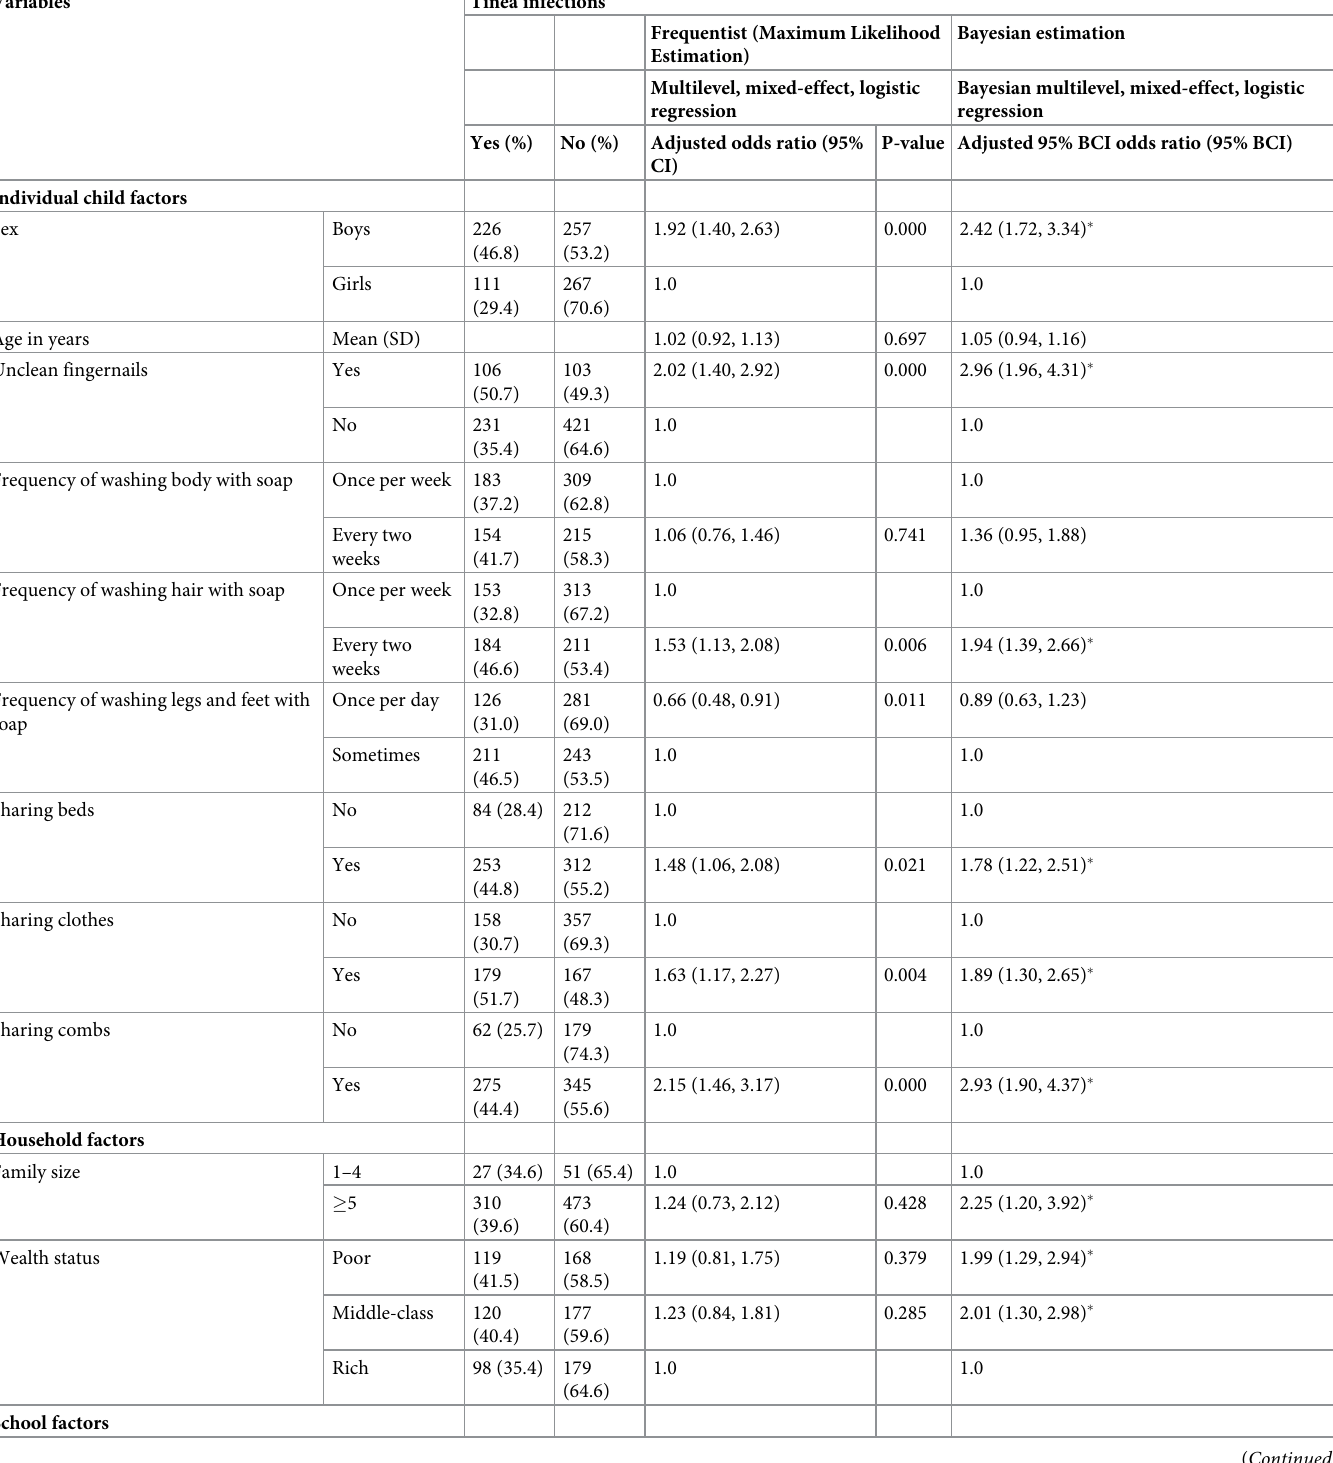
Table 4. Frequentist and Bayesian multivariate multilevel, mixed-effect, logistic regression analysis of tinea infections among schoolchildren in the Wonago dis- trict, southern Ethiopia,